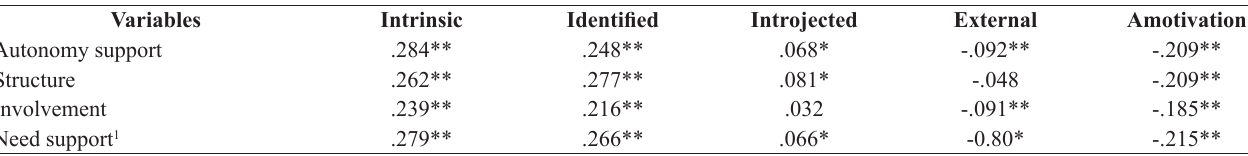
Table 5. Nomological validity between PESSp and PLOCQp Variables